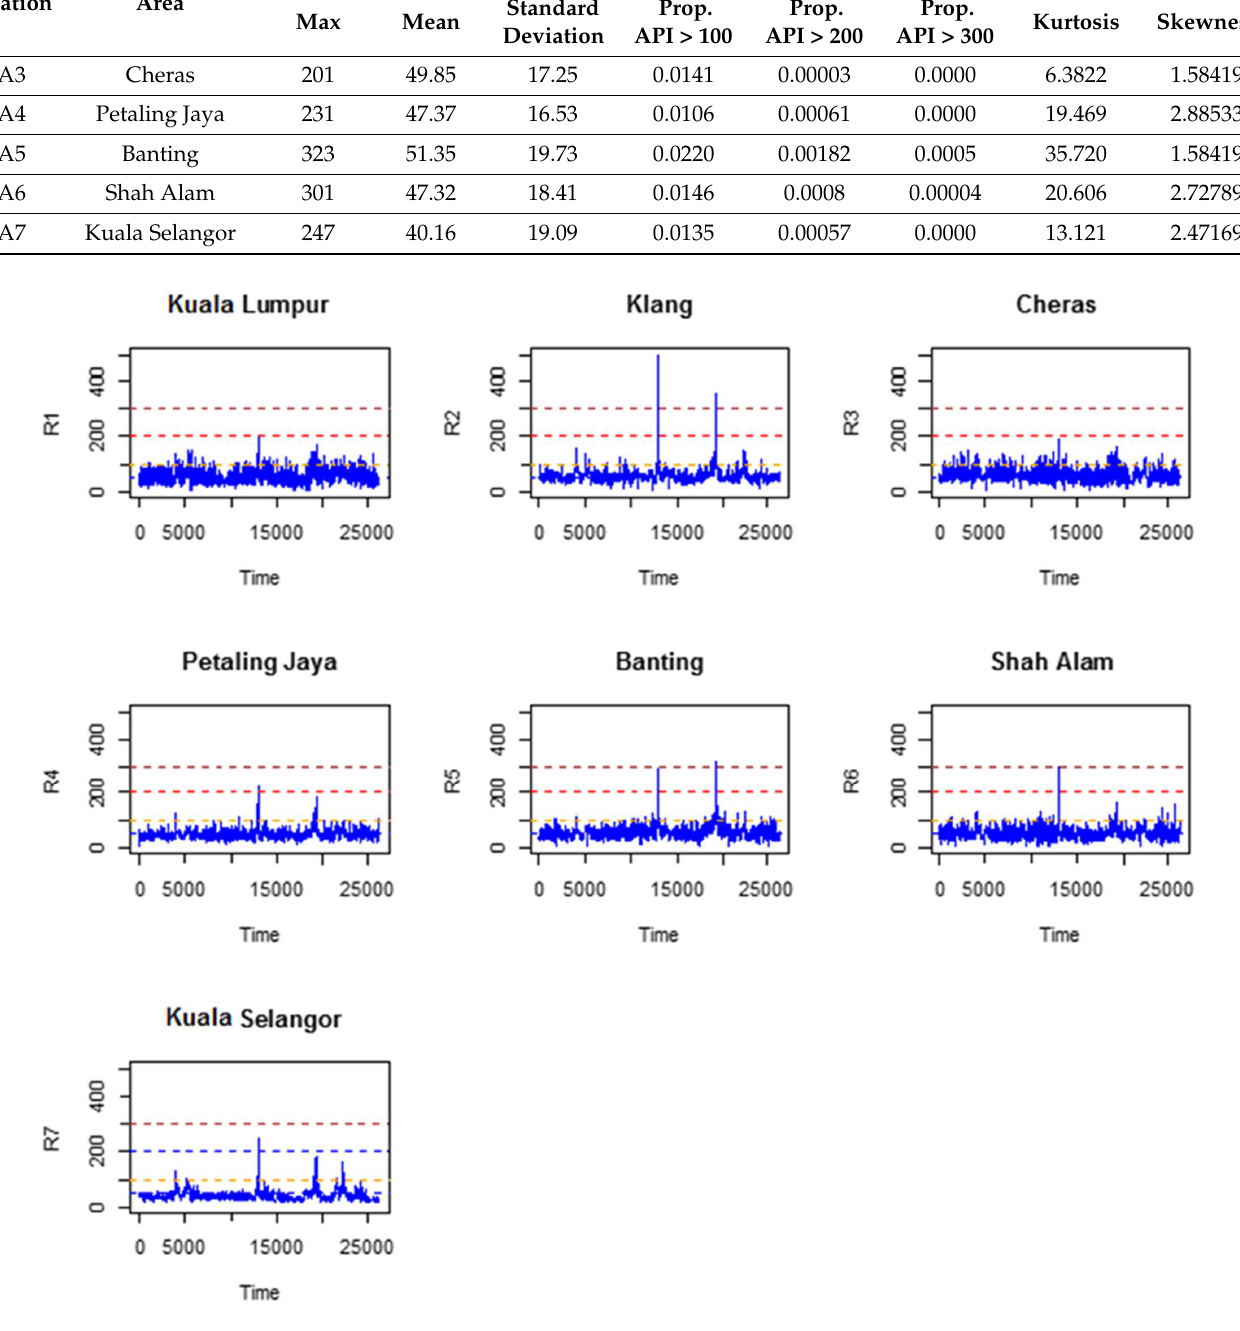
Figure 2. Temporal trend of hourly APIs for the stations considered in this